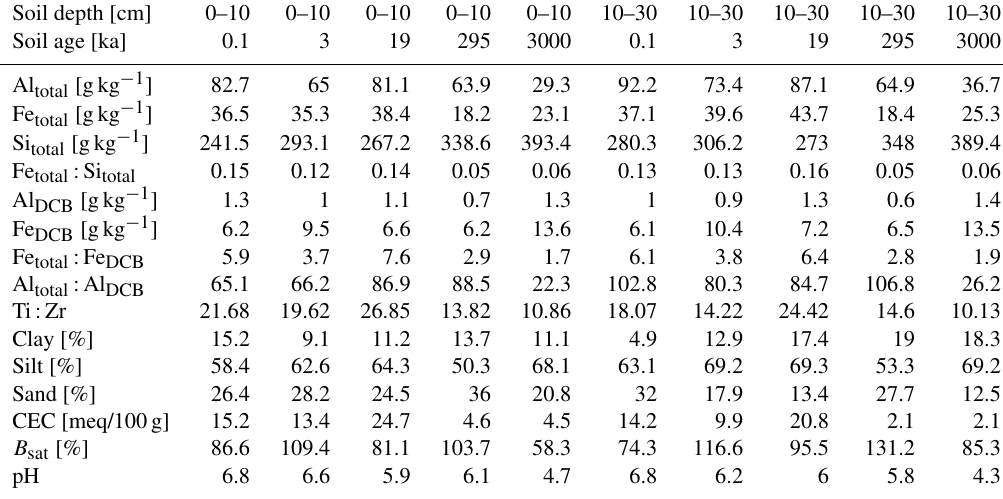
Table 2. Overview of soil mineralogy and texture changes with increasing soil age at 0–10 and 10–30cm depth ( n = 10). The mineralogy was measured using inductively coupled plasma atomic emission spectrometry (ICP-AES). Texture was quantified with a laser diffraction particle size analyser. Pedogenic oxides were extracted in duplicates with dithionite–citrate–bicarbonate